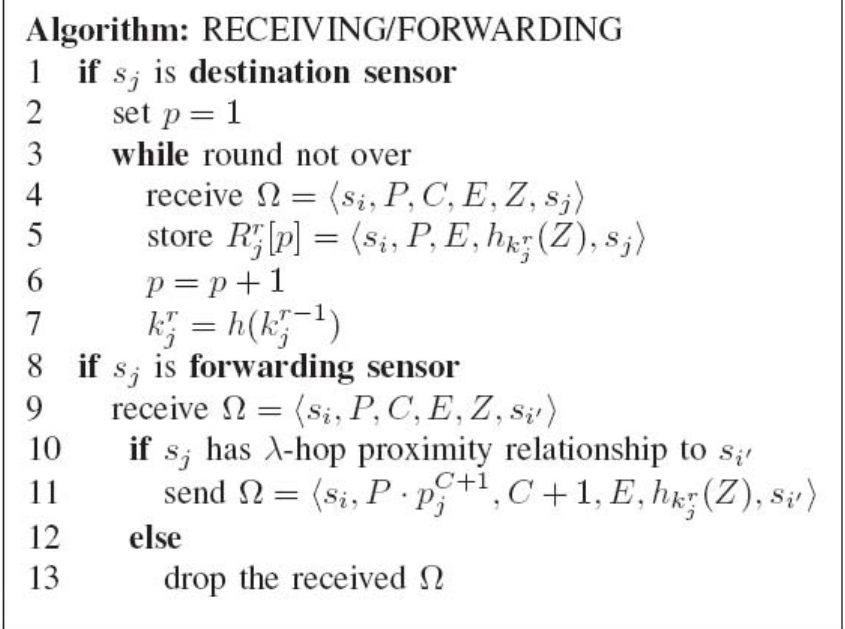
Figure 6. The algorithm of receiving/forwarding